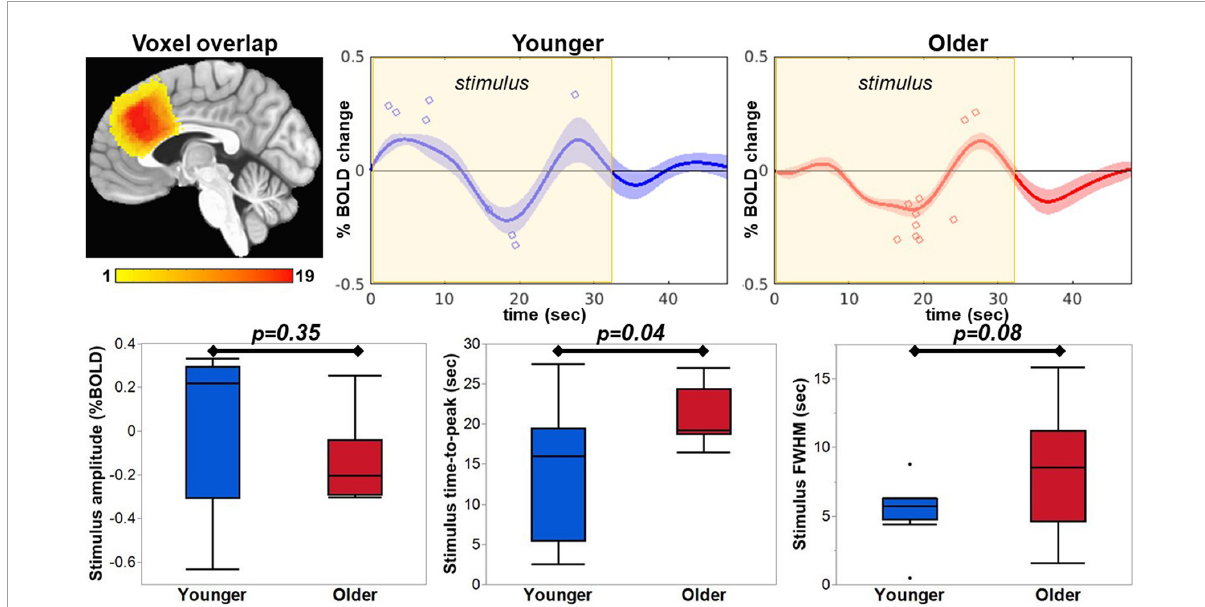
FIGURE6 The HRF was extracted from each participant’s MRS voxel location, which were in a similar location covering the pre-SMA as seen in the voxel overlap image. The maximum peak within the stimulus window was extracted and is indicated with a blue circle for the younger group and red circle for the older group on the respective average HRF. The extracted amplitude, time-to-peak, and FWHM are plotted for comparison between the groups.